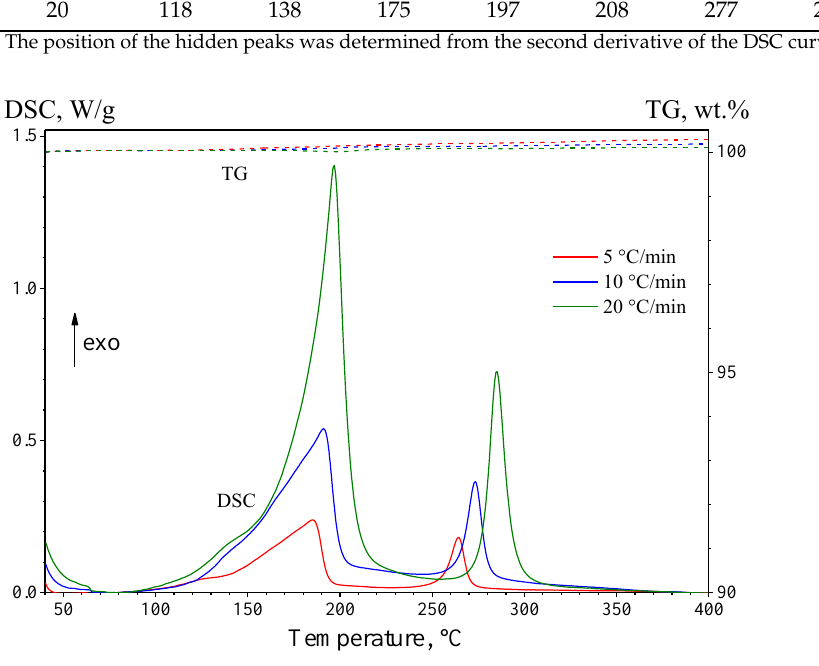
Table 4. Characteristic temperatures of the main exothermic peaks on the DSC curve correspond- ing to thermochemical transformations in the (Cu/a-Si) 30 multilayer films.